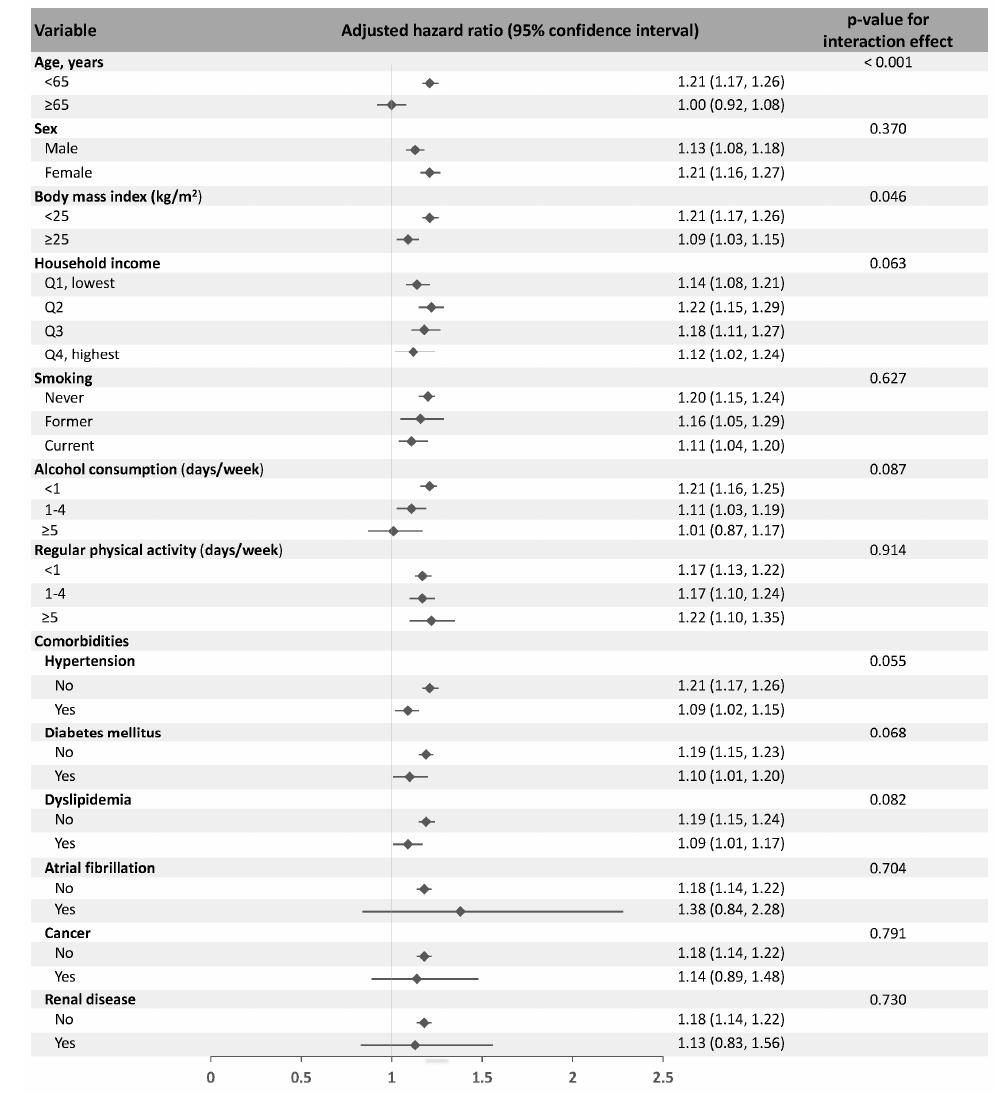
Figure 3. The subgroup analysis to determine the association between the presence of periodontitis and the occurrence of Meniere’s disease according to age, sex and covariates. The multivariable model included sex, age, body mass index, income levels, smoking, alcohol consumption, regular physical activity, hypertension, diabetes mellitus, dyslipidemia, atrial fibrillation, cancer and renal disease. Q, quartile.